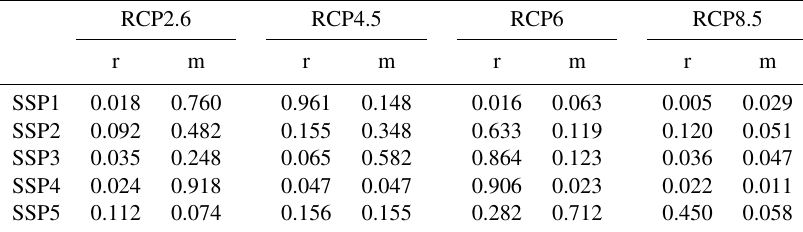
Table A3. Matrices for reference (r) and mitigation (m) scenarios with probabilities that a given SSP results in a given RCP.